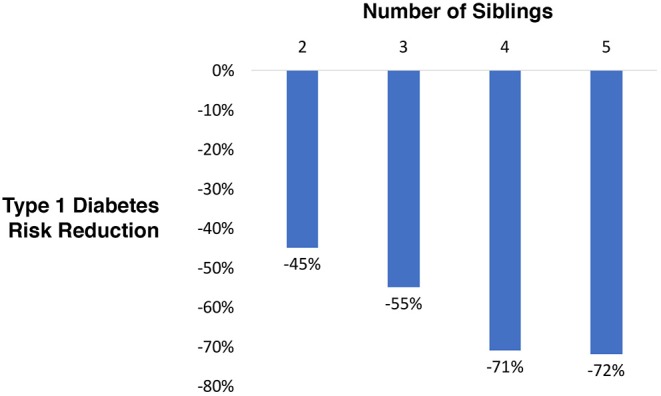
Relative type 1 diabetes risk reduction when selecting a sibling using blinded genetic testing for polygenic scoring compared to random selection.